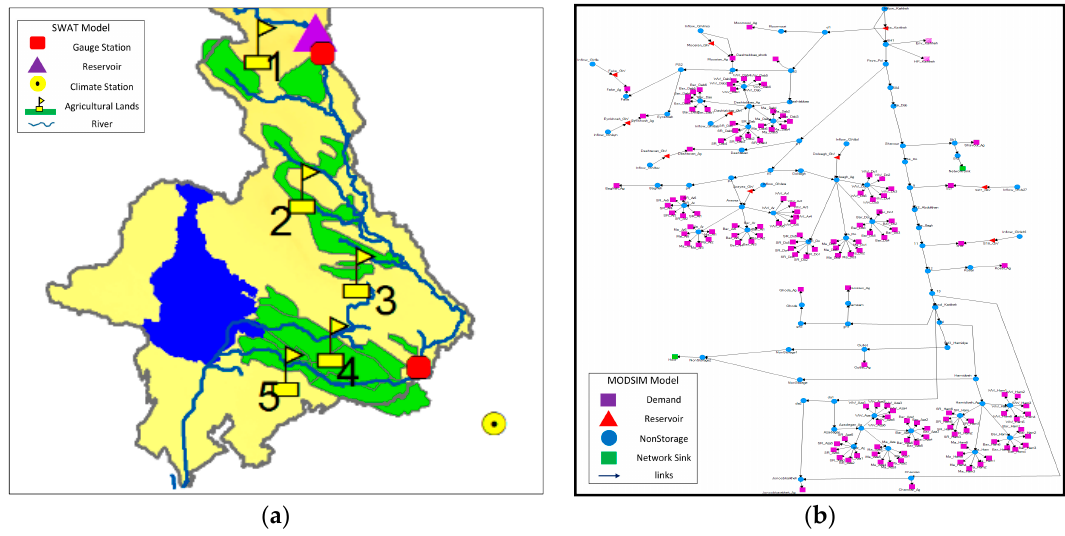
Figure 2. ( a ) LKRB system in the SWAT River network and ( b ) water allocation system in MODSIM.